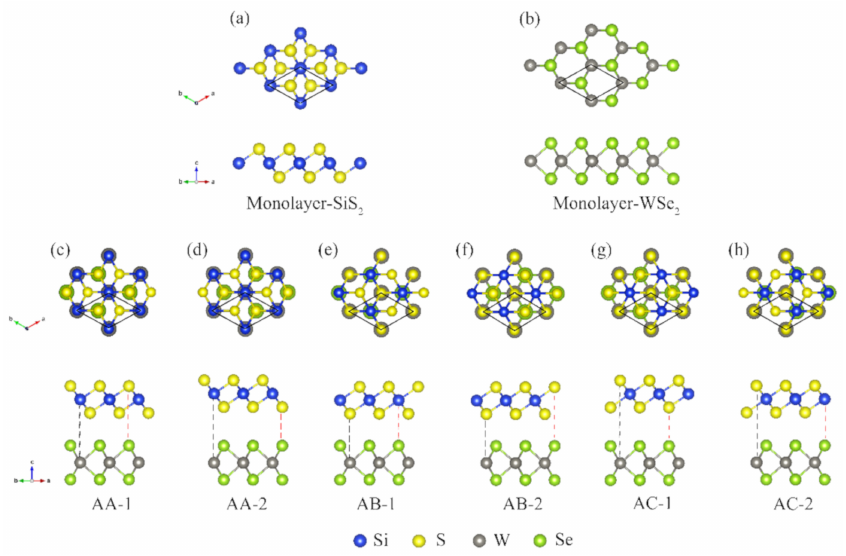
Figure 1. Top and side views of ( a ) monolayer SiS 2 , ( b ) monolayer WSe 2 and ( c – h ) SiS 2 / WSe 2 hetero-bilayers. For AA-1 stacking, W atoms and Se atoms are located directly under the Si atoms and S (top sub-plane) atoms, respectively. For AB-1 stacking, W atoms and Se atoms are positioned just below the S atoms (bottom sub-plane) and Si atoms, respectively. For AC-1 stacking, W atoms and Se atoms are both positioned directly below the S atoms (top sub-plane and bottom sub-plane). The AA-2 (AB-2, AC-2) configuration is achieved by fixing the top layer of SiS 2 and rotating the WSe 2 layer of AA-1 (AB-1, AC-1) by 180 degrees with the “c” axis. The calculated binding energies for